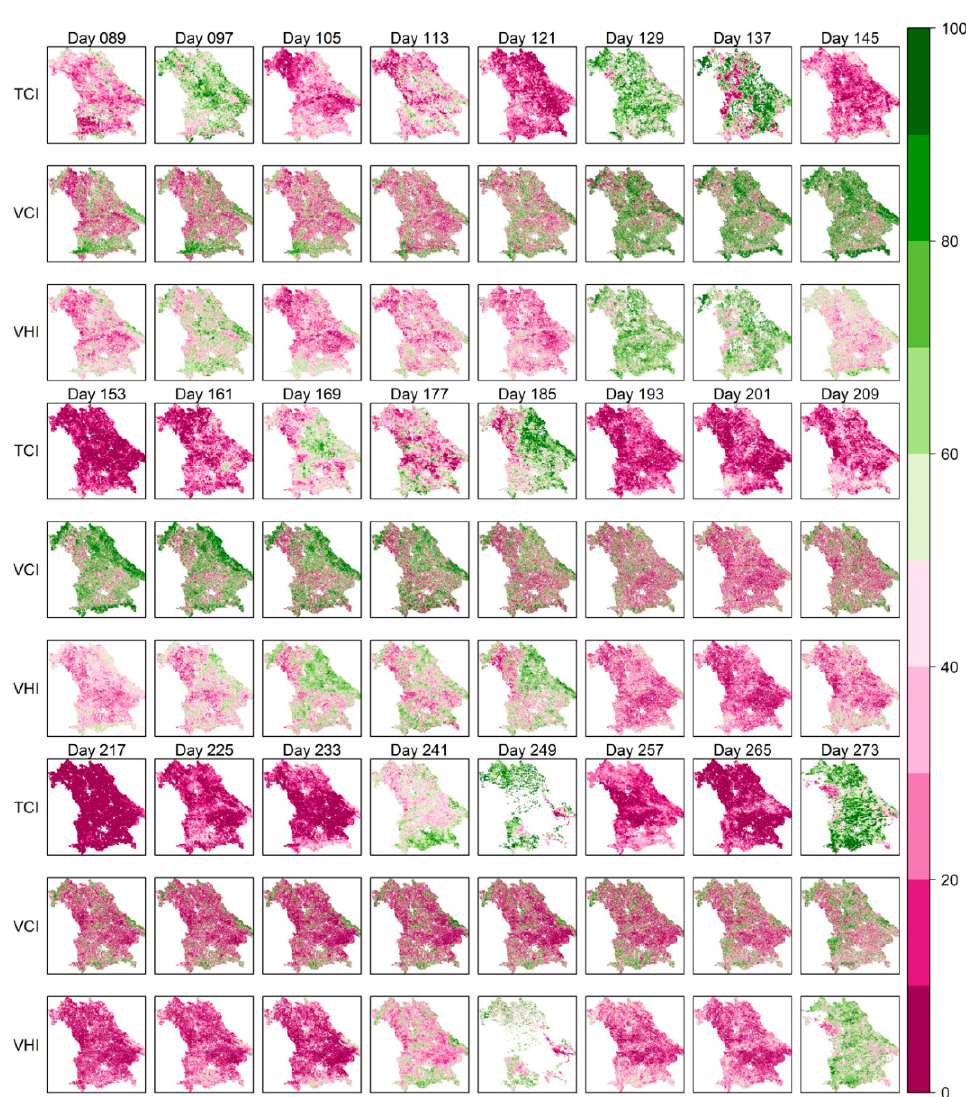
Figure 6. TCI, VCI, and VHI in Bavaria in the drought year 2003 from day 089 (30 March) to day 273 (30 September).